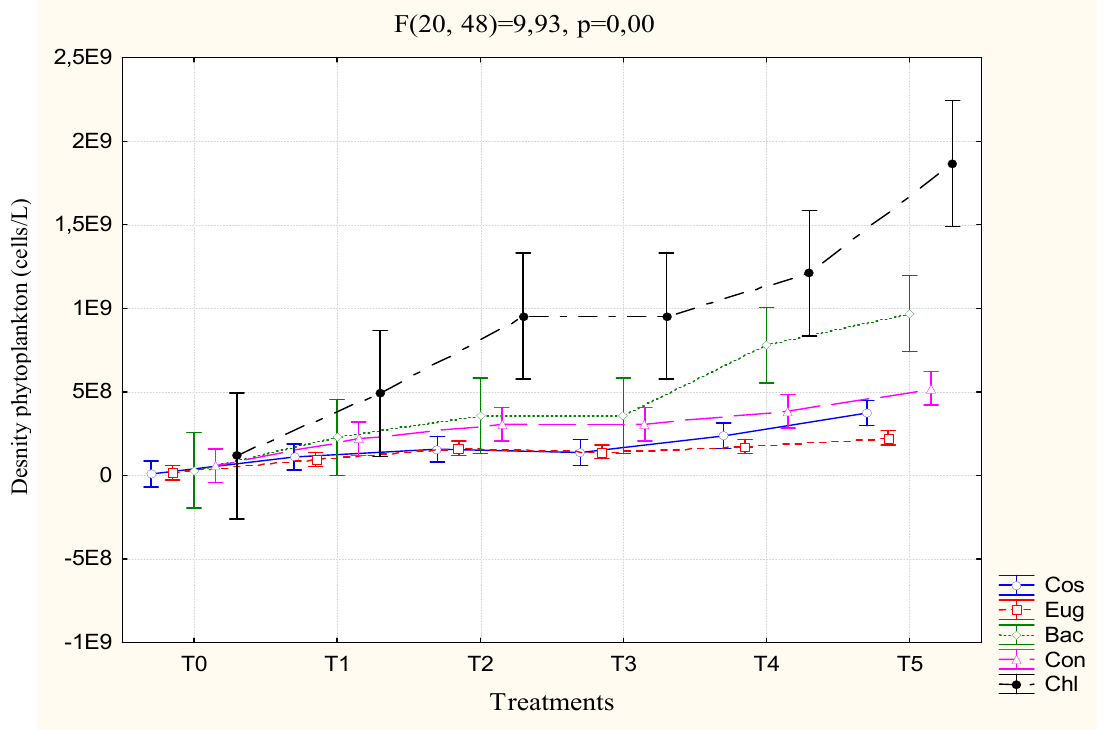
Figure 4. Evolution of different phytoplankton phylum. T: treatments Cos: Coscinodiscophyceae, Eug: Euglenophyceae, Bac: Bacillariophyceae, Con: Conjugatophyceae, Chl: Chlorophyceae. T0 (the control), T1, T2, T3, T4, T5 corresponding respectively to 0, 300, 600, 900, 1200, 1500 g of dry rabbit manure (RM).